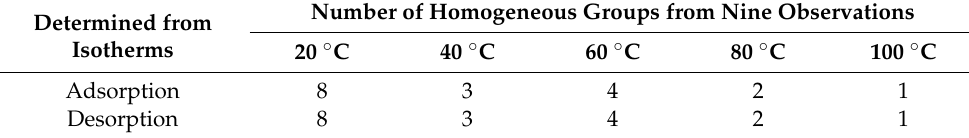
Table 5. Goodness of fit of the